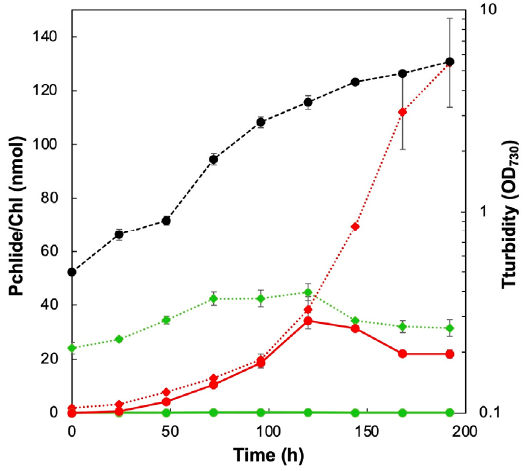
Figure 2. Pchlide accumulation of YFC2 during heterotrophic growth in the dark. Filled black circles indicate the turbidity (OD 730 ). Chl (green) and Pchlide (red) contents in the culture media (circles, solid lines) and cells (diamonds, dotted lines) in 10 mL.